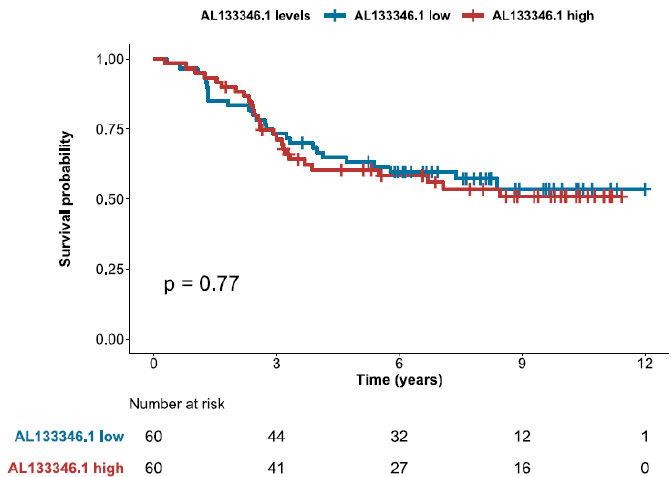
Figure A5. Kaplan ‐ Meier overall survival curves of pediatric B ‐ ALL patients divided in two groups according to whether AL133346.1 expression was above or beyond the median: “AL133346.1 high” and “AL133346.1 low”. The p ‐ value of Cox univariate analyses are shown.